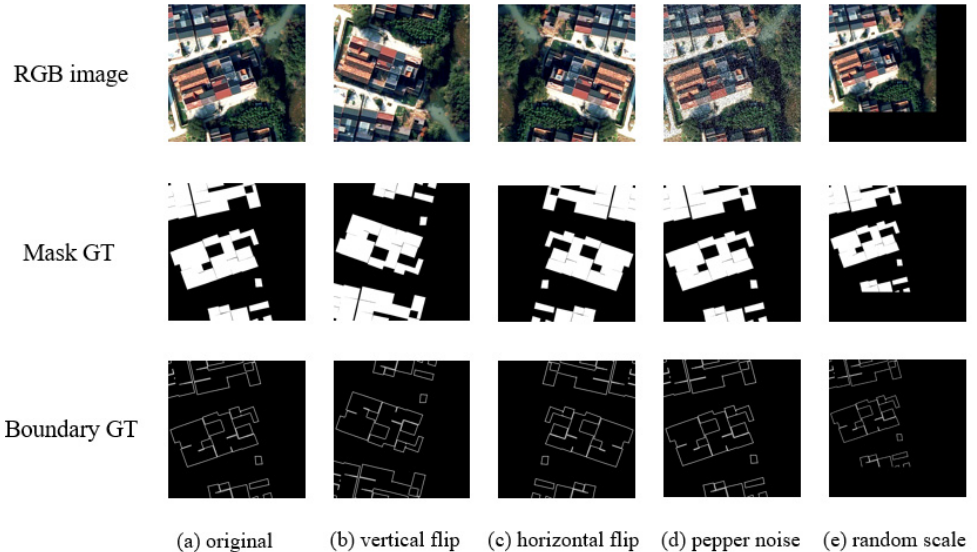
Figure 5. Examples of data augmentation by several methods.